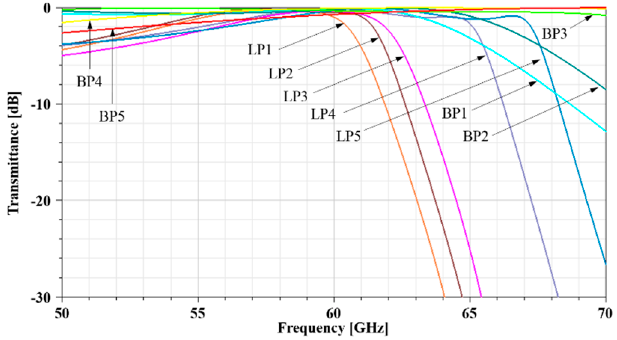
Figure 7. Simulated transmittance (s21) of both low-pass and band-pass unit cells with different sized patches and different width grid.